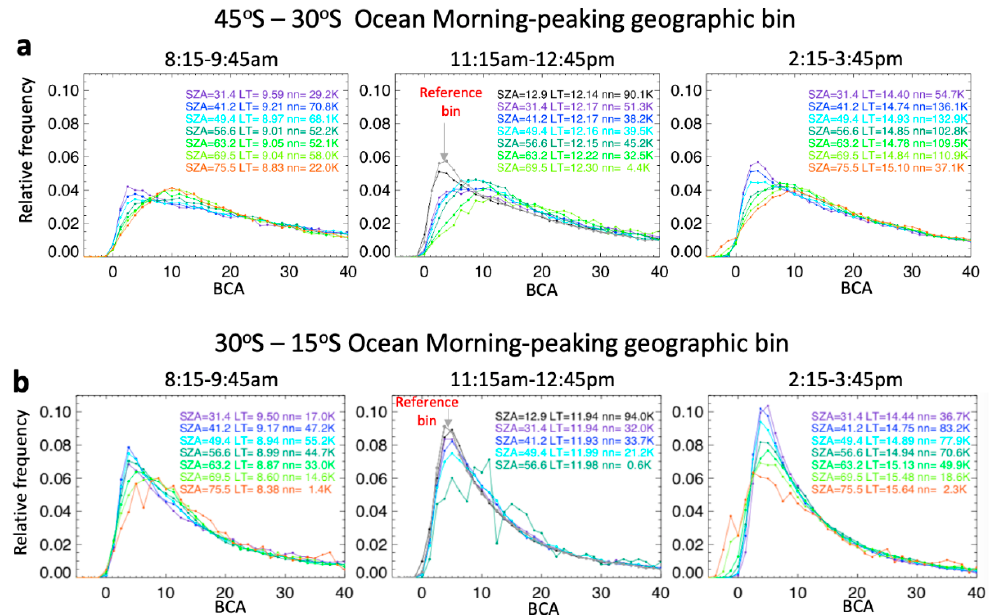
Figure 3. Relative frequency (histograms) of BCA for the ocean morning-peaking geographic bin in two latitude bands ( a ) 45°S to 30°S and ( b ) 30°S to 15°S. These areas are shown in Figure 2a by the red-colored cells over ocean. The left two panels are for observations sampled in the morning (local time), the middle panels close to noon, and the right panels in the afternoon. Within each local time bin, the observations are further categorized by solar zenith angle. The colored legends show the mean solar zenith angle, the average local time, and the number of samples (nn) for each bin. An example of a reference histogram, as shown by the gray trace in the local noon time bin, is used when the solar zenith angle at local noon for the day and latitude of the observation falls in the first bin (0.0° to 25.8° bin with mean of 12.9°); observations with a local-noon solar zenith angle that fall in other bins will be adjusted using a different reference distribution (see text). These two geographic bins have a large number of samples and yield smooth histograms even when segregated by solar zenith angle. Some geographic bins have so few observational samples that no diurnal corrections can be performed (e.g., afternoon peaking marine clouds in the 45°S to 30°S latitude band). A frequency distribution of cloud optical depths inferred from nadir observations from the global area coverage (GAC) advanced very high-resolution radiometer (AVHRR) channel 1 (0.63 um) over marine stratocumulus clouds showed a similar shift to higher cloud optical depths with an increasing solar zenith angle (Figure 8 of Loeb and Coakley [22]). While it is beyond the scope of this study to determine if unaccounted 3D radiative transfer effects are the cause of the solar zenith angle